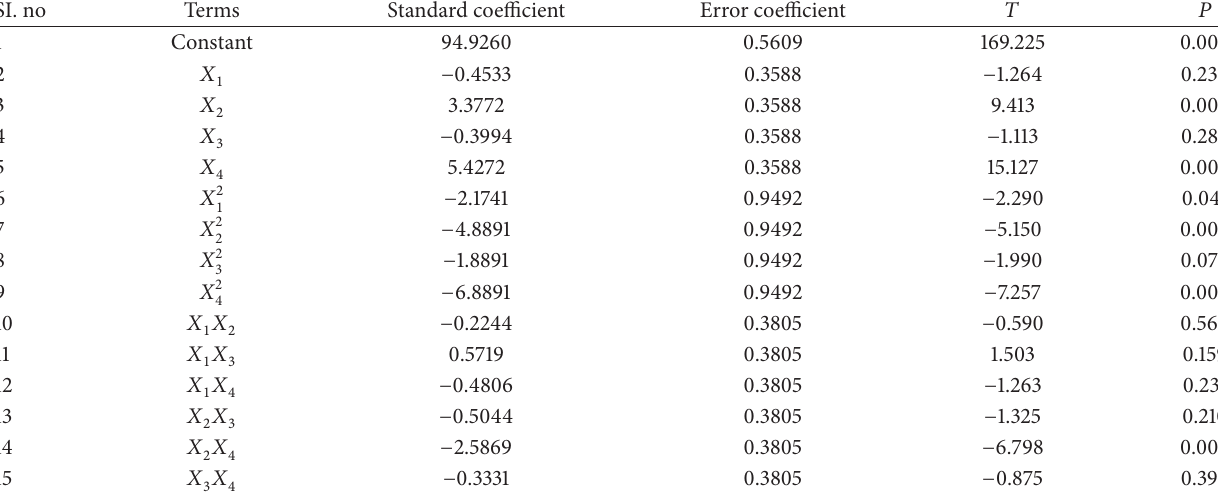
Table 3: Results of significance test on the nonlinear model coefficients, standard errors, 𝑇 statistics, and 𝑃 values for the lipase activity (coded